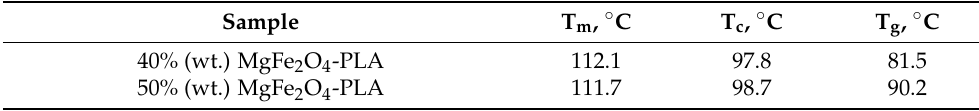
Figure 8. DSC thermograms of MgFe 2 O 4 –PLA composites. Table 1. DSC data of MgFe 2 O 4 -PLA composites.